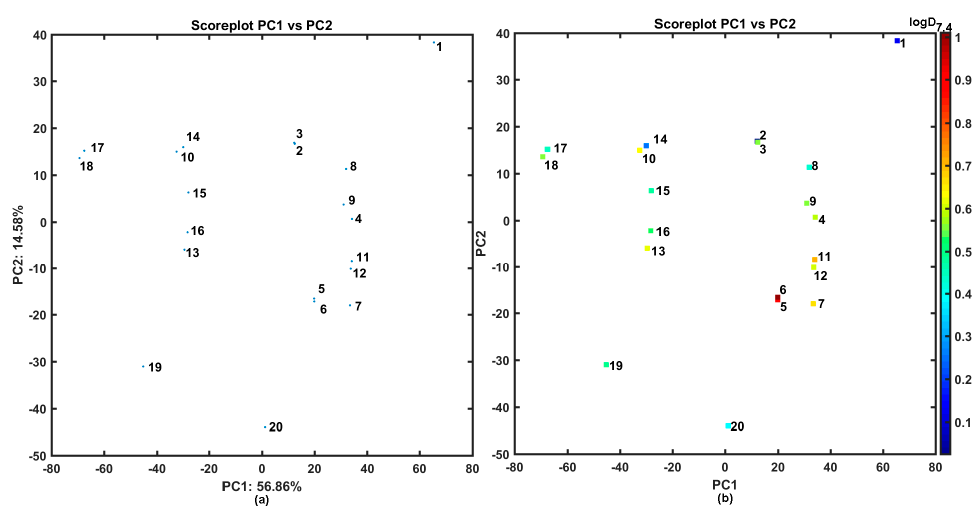
Figure 2. Projection of cinnamic acid anilides 1 – 20 on plane defined by first vs. second principal components for Dragon descriptors ( a ) with experimental logD 7.4 ( b ). Colors code numerical values of logD at pH = 7.4.